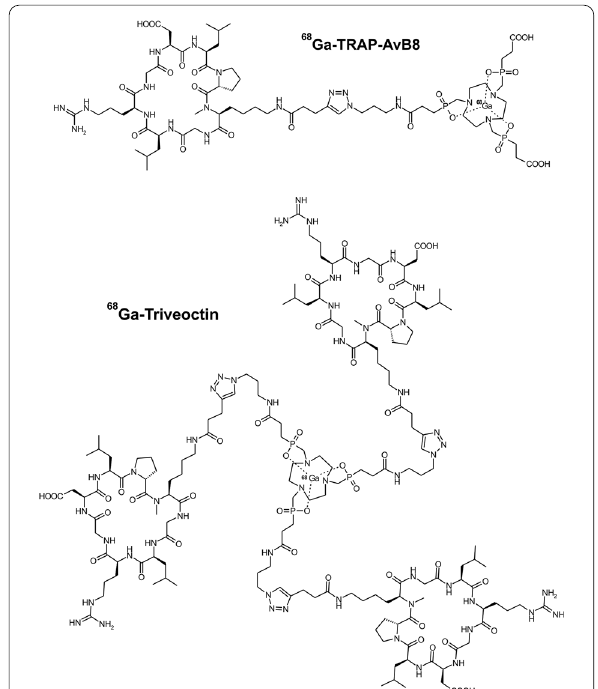
Fig. 1: 68 Ga-TRAP-AvB8 and 68 Ga-Triveoctin, two gallium-68-labeled conjugates of the peptide c(GLRGDLp( N Me)K) (AvB8) for in-vivo mapping of αvβ8-integrin expression by